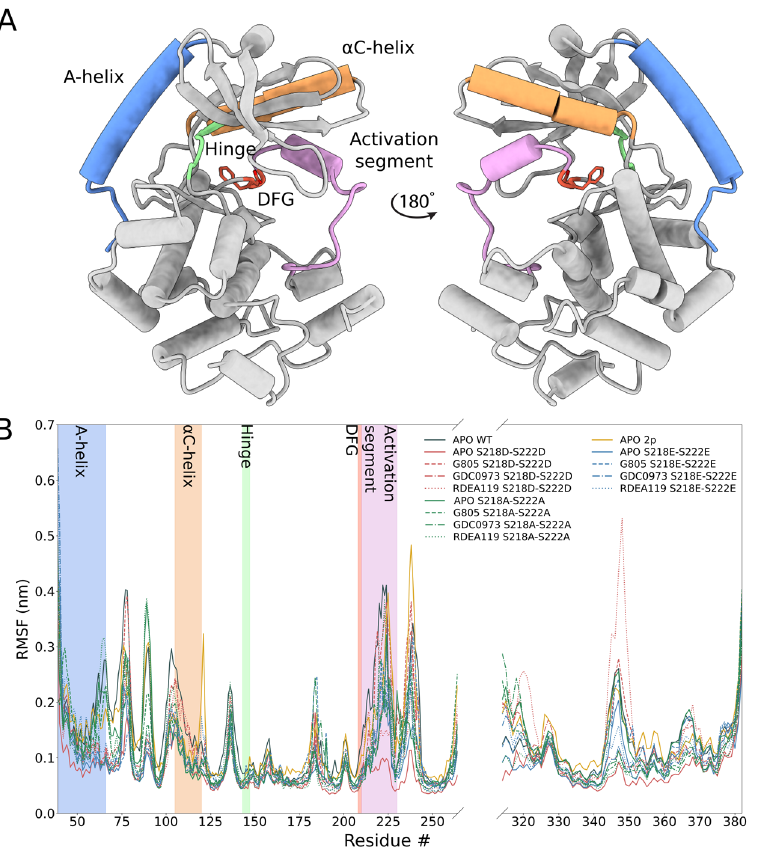
Figure 3. Structural overview of phosphorylation-mimetic MEK1 mutants: ( A ) Three-dimensional representation of the human MEK1 model used in MD simulation experiments. Coloring of secondary structure elements that undergo rearrangement during activation conforms with those regions highlighted in the RMSF analysis. Residue # represents amino acid position number. ( B ) Root-mean-square fluctuation (RMSF) analysis of WT MEK1, MEK1-S218D-S222D, MEK1-S218E-S222E, MEK1-S218A-S222A and corresponding ligand-bound complexes shows increased backbone displacement in and around regions engaged in kinase activation for Asp/Asp mutants relative to Glu/Glu and Ala/Ala mutants, signifying that open conformations are more prevalent in S218D-S222D systems.